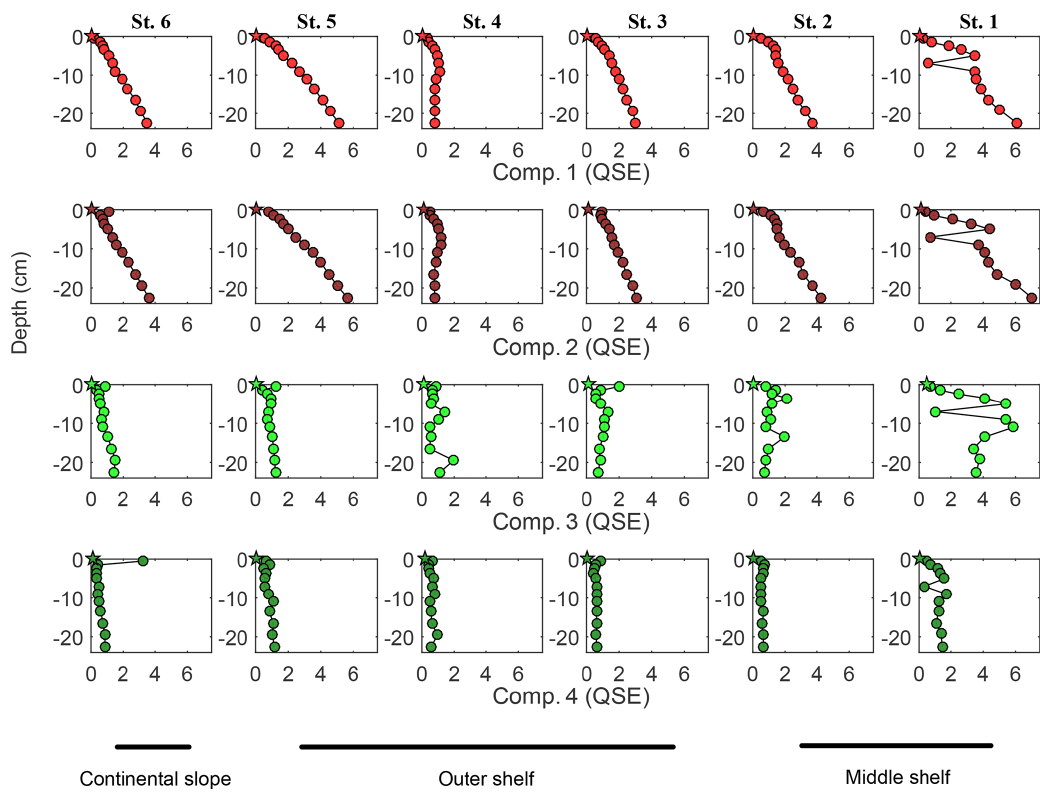
Figure 6. Pore water FDOM component distribution within the sediments: depth profiles. Humic-like Comp. 1 and Comp. 2 represented by light and dark red symbols, respectively. Amino-acid-like Comp. 3 and Comp. 4 represented by light and dark green symbols, respectively. Circles represent concentration/value, measured in the pore water sample; stars represent the initial concentration/value of the bottom water.